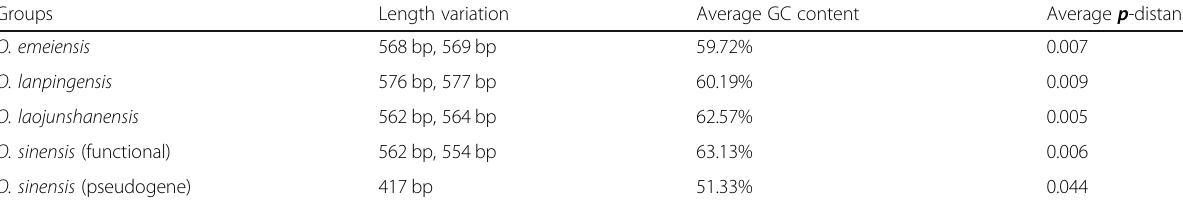
Table 1 ITS1 – 5.8S-ITS2 Length variation, GC content and p -distance analyses of O. sinensis and related species studied